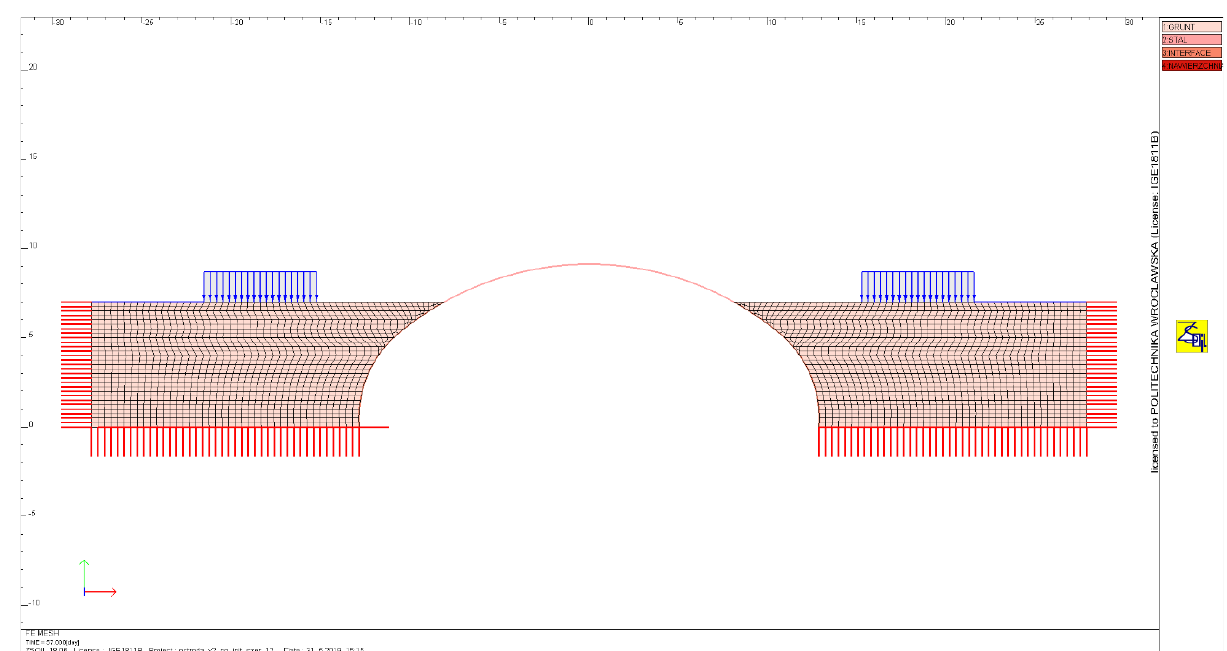
Figure 9: Selected phase of